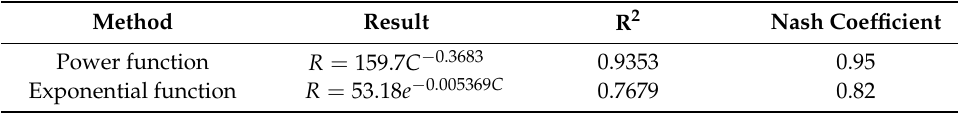
Table 2. Resistivity–chloride fitting results and error assessment